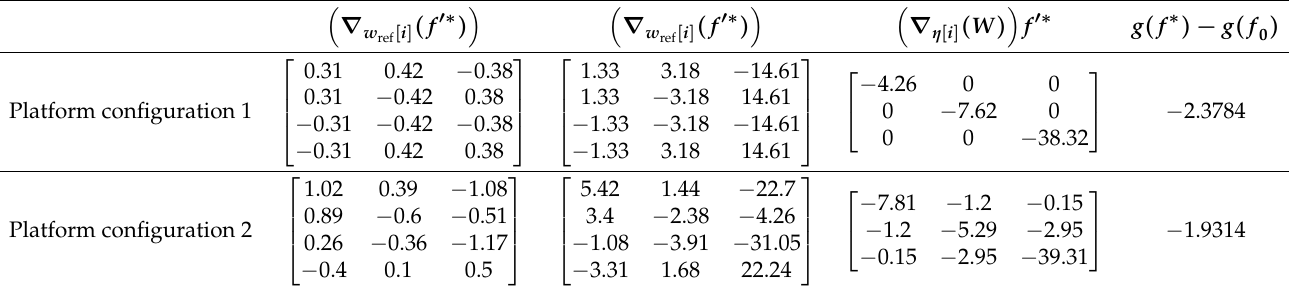
Table 3. Terms of (8), for the two platform configurations of Figure 9/Table